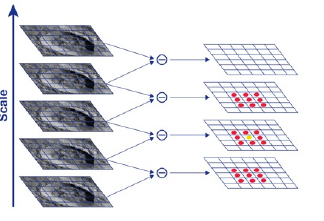
Figure 3. Left: Multiscale signal representation or image pyramid for Ahuna Mons. Centre: BRIEF binary feature descriptor. p(x) or p(y) are the intensity of image pixel (p), respectively, at a point x and y. In the case where the pixel at point y is greater than the pixel at point x, it is marked as 1 at points x and y; otherwise it is marked as 0. This is done for n location pairs of image p, n being the length of the binary feature vector. Right : ORB keypoint analysis for the Ahuna Mons image.